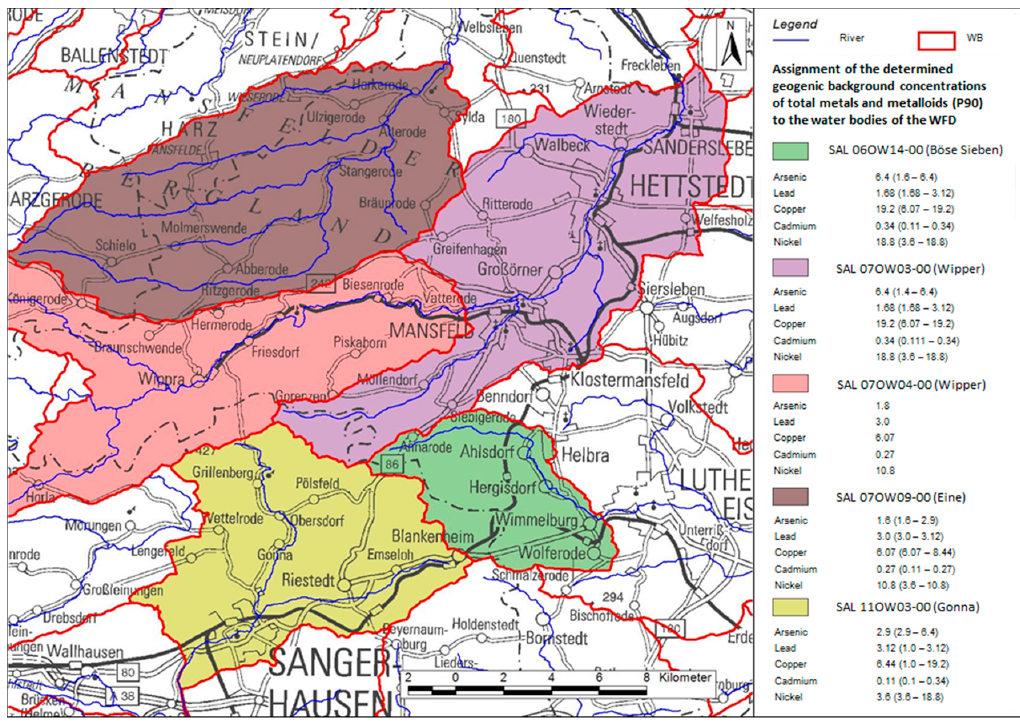
Figure 3. Sample for the determination of the geogenic background concentrations of total metals and metalloids (P90) of ARLs to water bodies.